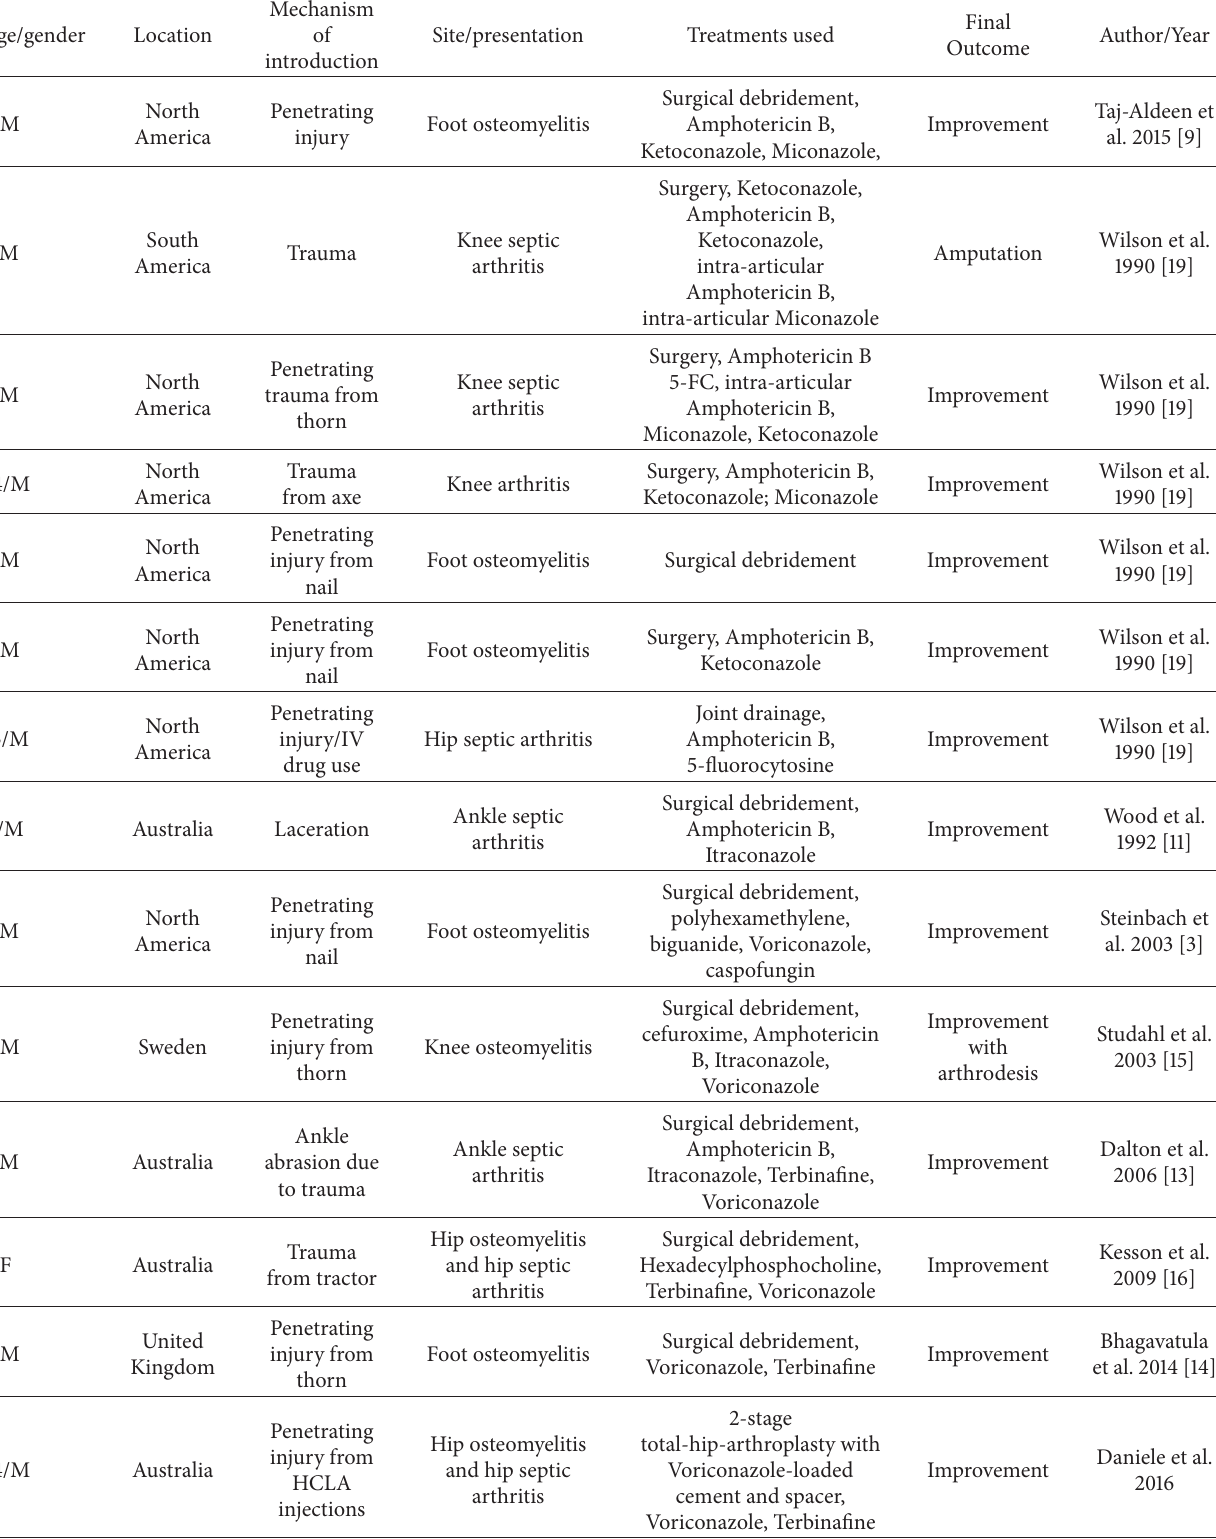
Table 1: Reported Scedosporium prolificans -associated osteomyelitis and/or septic arthritis infections from penetrating trauma in immuno- competent